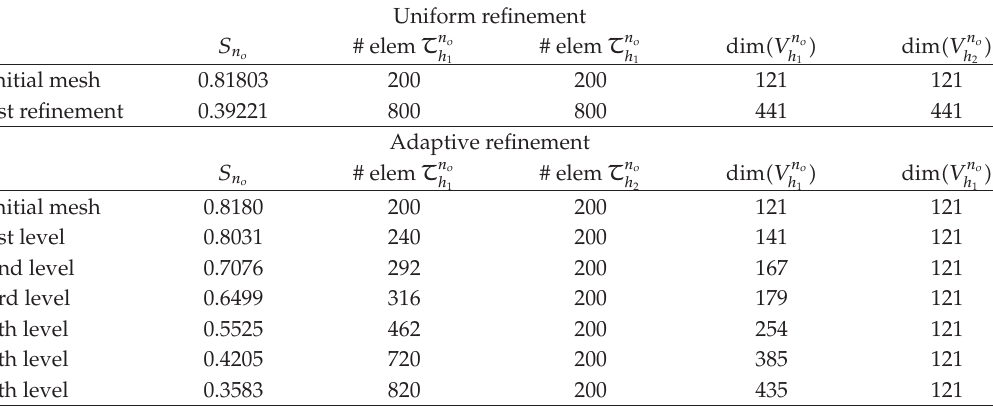
Table 7: Adaptive versus uniform